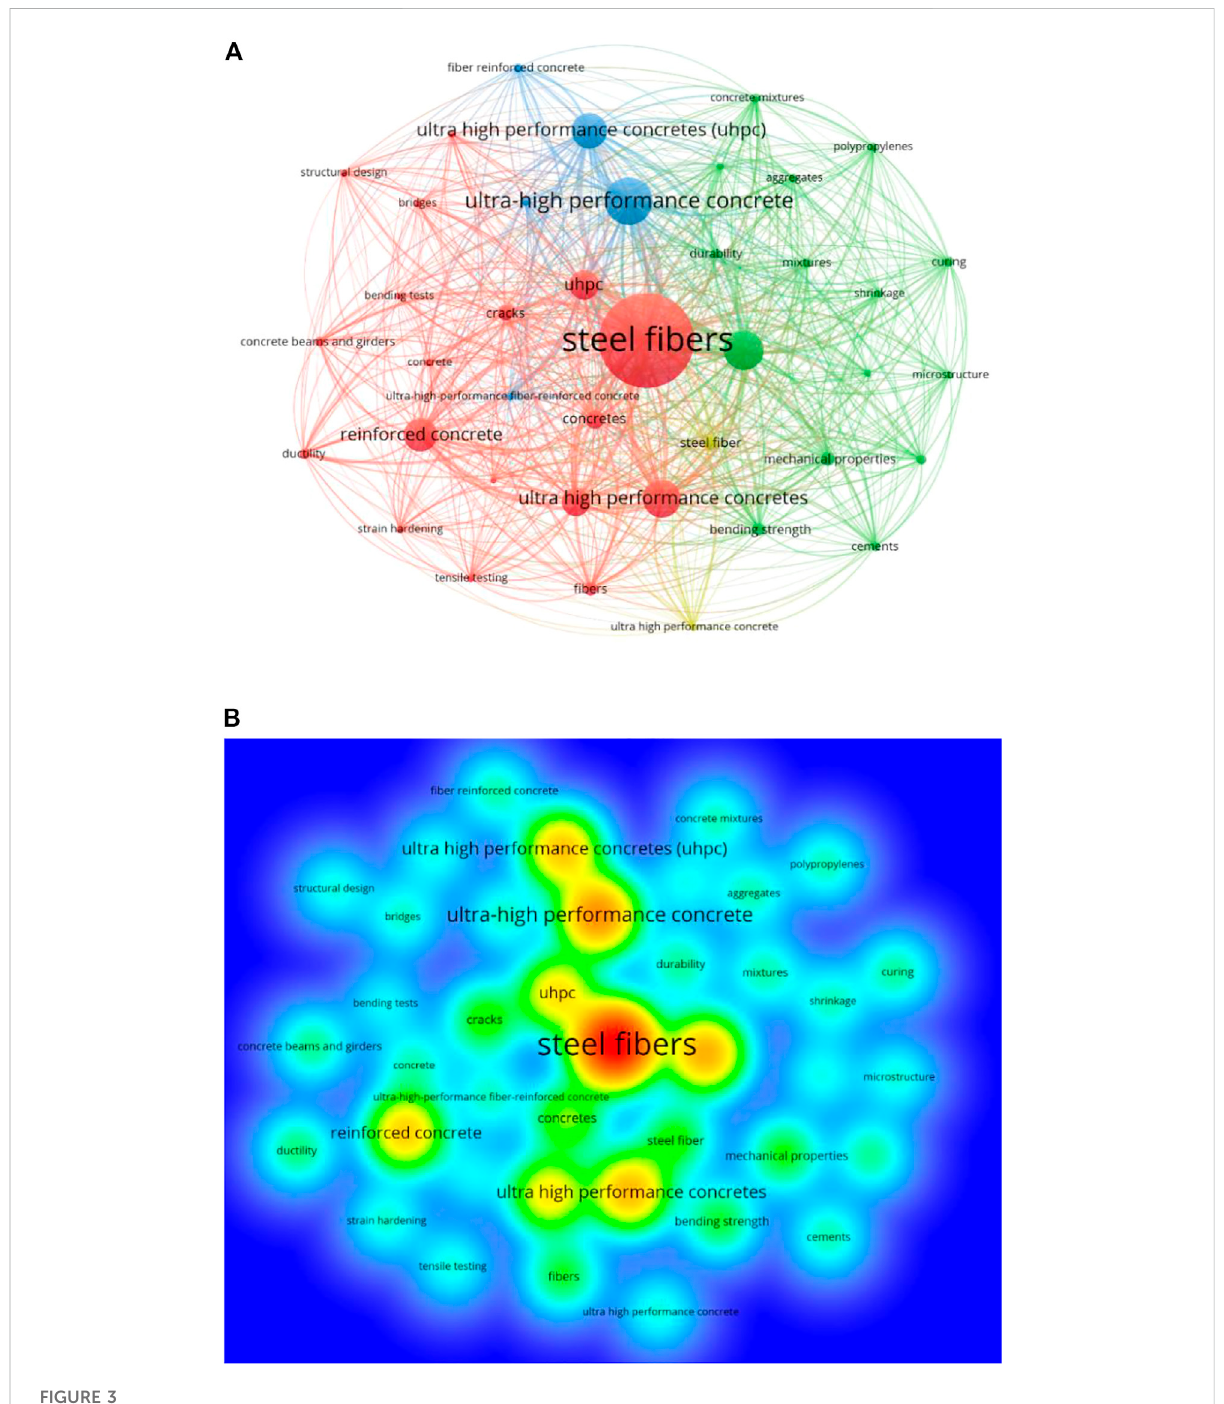
FIGURE 3 Keyword analysis: (A) scienti fi c visualization and (B) density visualization.